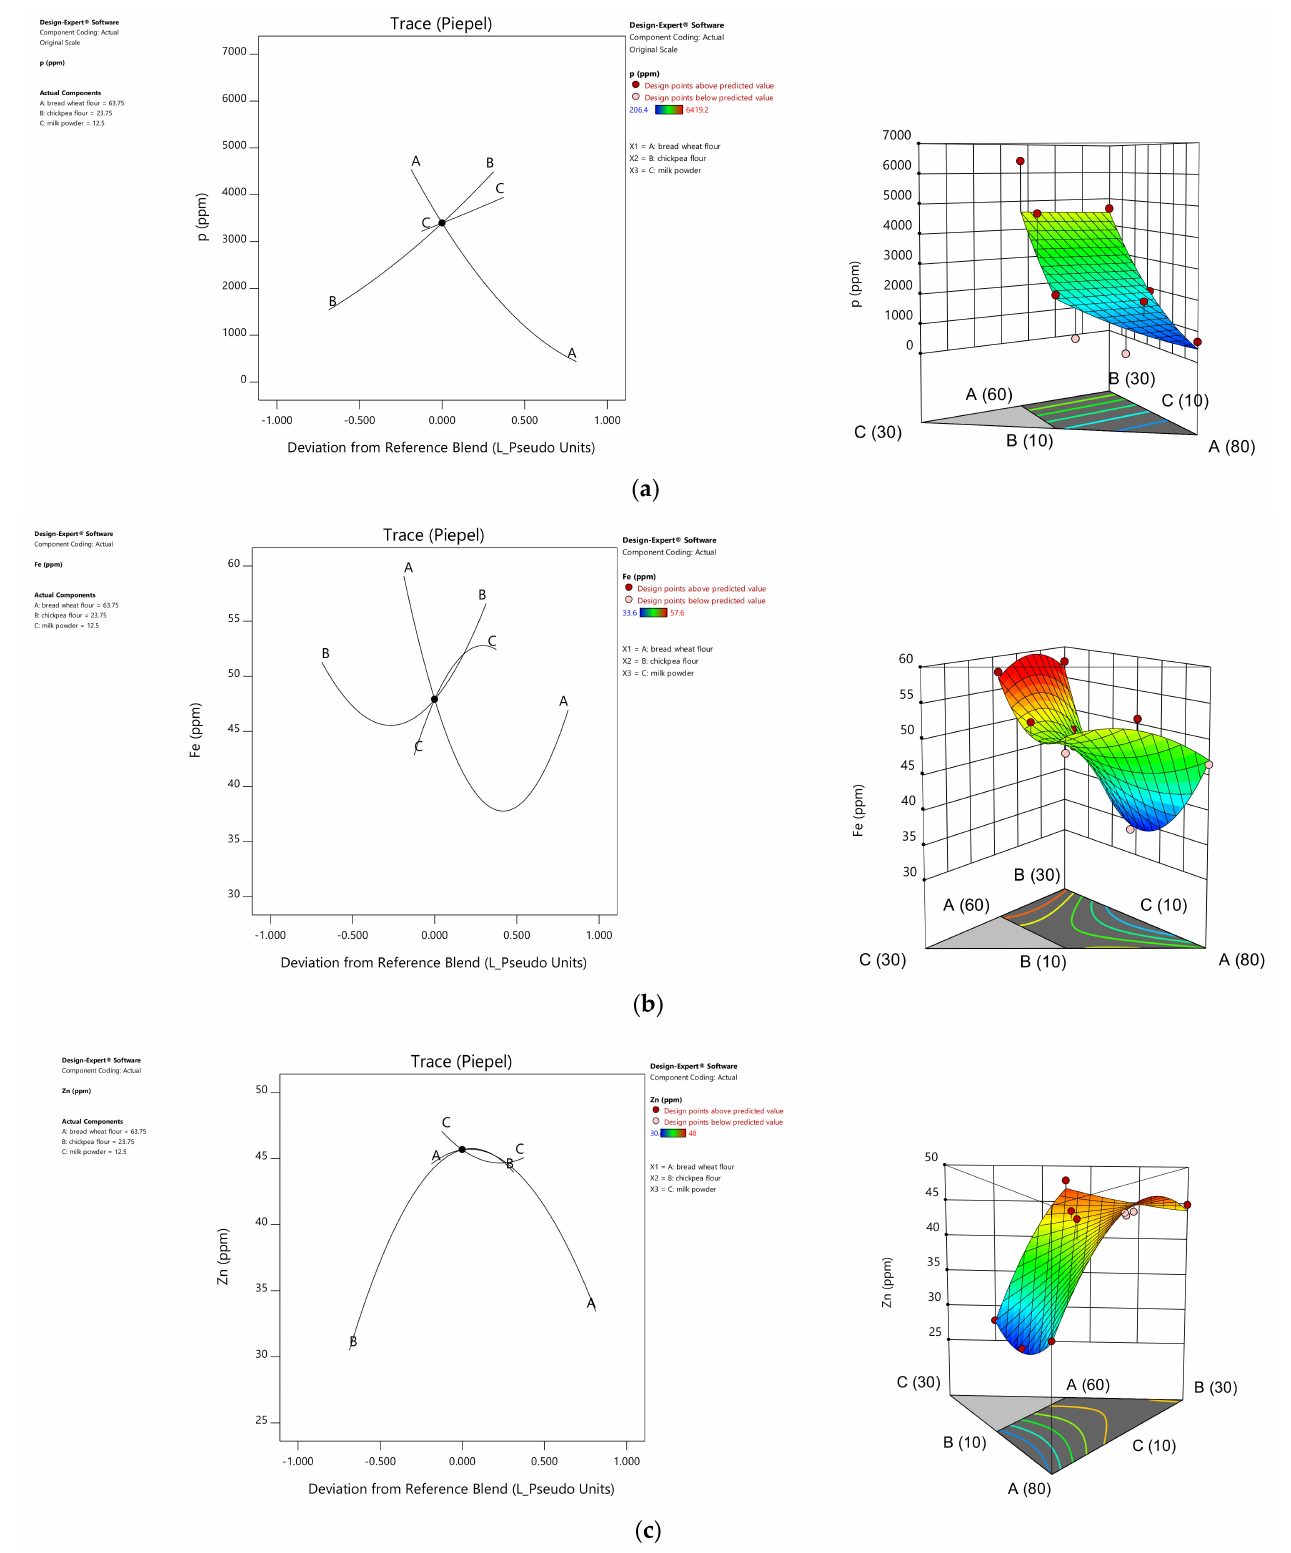
Figure 2. Trace plot curves and response surface (2D and 3D) presentations of phosphorus ( a ), iron ( b ), and zinc ( c ) variation in flour blends (A: Bread wheat, B: Chickpea, C: Milk